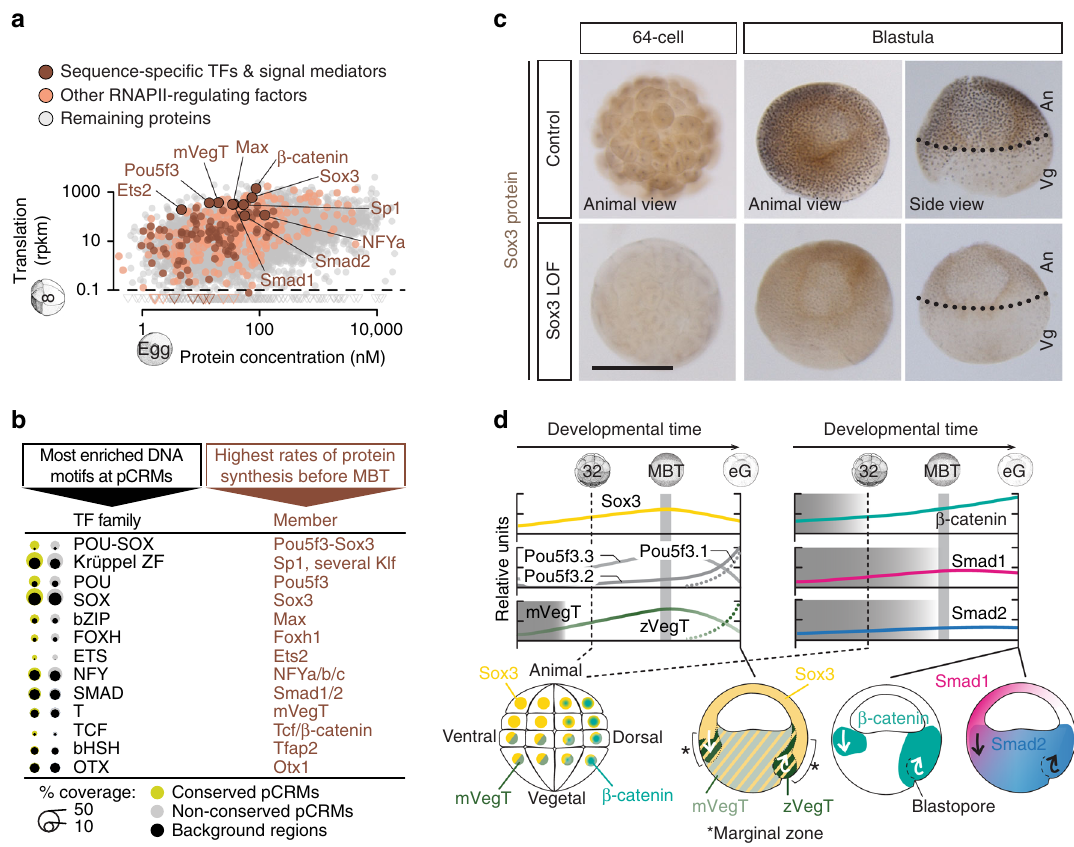
Fig. 2 Search for ZGA-critical proteins based on their signi fi cantly enriched DNA recognition motifs at accessible and engaged (RNAPII + /H3K4me1 + ) pCRMs and their high translation frequency before the MBT. a Maternal protein concentrations in the egg 13 versus ribosome footprint (translation) levels at the 8-cell stage 14 . Most frequently translated representatives of various TF families are labelled. b Matching canonical pCRM-enriched DNA motifs (sorted by statistical signi fi cance) with frequently translated TFs and signal mediators. c WMIHC of Sox3 protein in control and Sox3 loss-of-function (LOF) embryos at the 64-cell and blastula stage. Nuclear accumulation of Sox3 protein was detected in both the animal (An) and vegetal (Vg) hemisphere of control embryos. Scale bar, 0.5 mm. d Graphical illustration of protein levels (derived from mass spectrometry data 42 ) and nuclear localisations (mainly derived from WMIHC, see references below) of selected TFs and signal mediators based on our and previously published results: Sox3 (this study and ref. 50 ), mPouV (Pou5f3.2 and Pou5f3.3) and (zygotic) Pou5f3.1 (deduced from transcript data 15 ), mVegT and zVegT 16 , β -catenin 10,17 , Smad1 (this